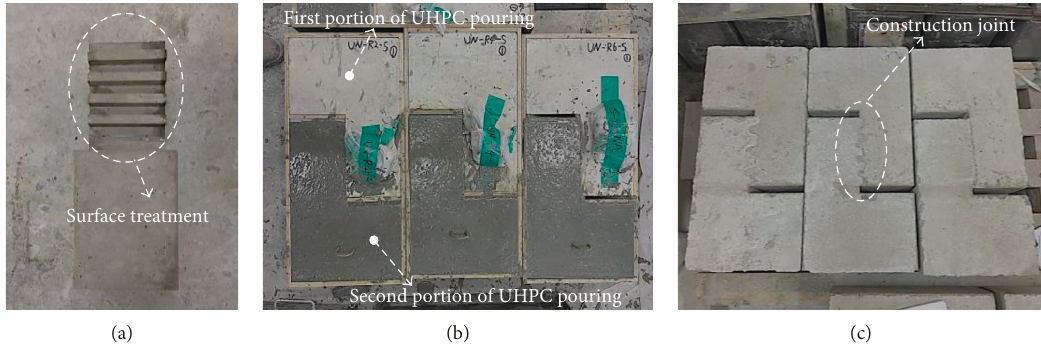
Figure 5: Specimen preparation: (a) removal of forms; (b) second portion of UHPC; (c) cured specimens.